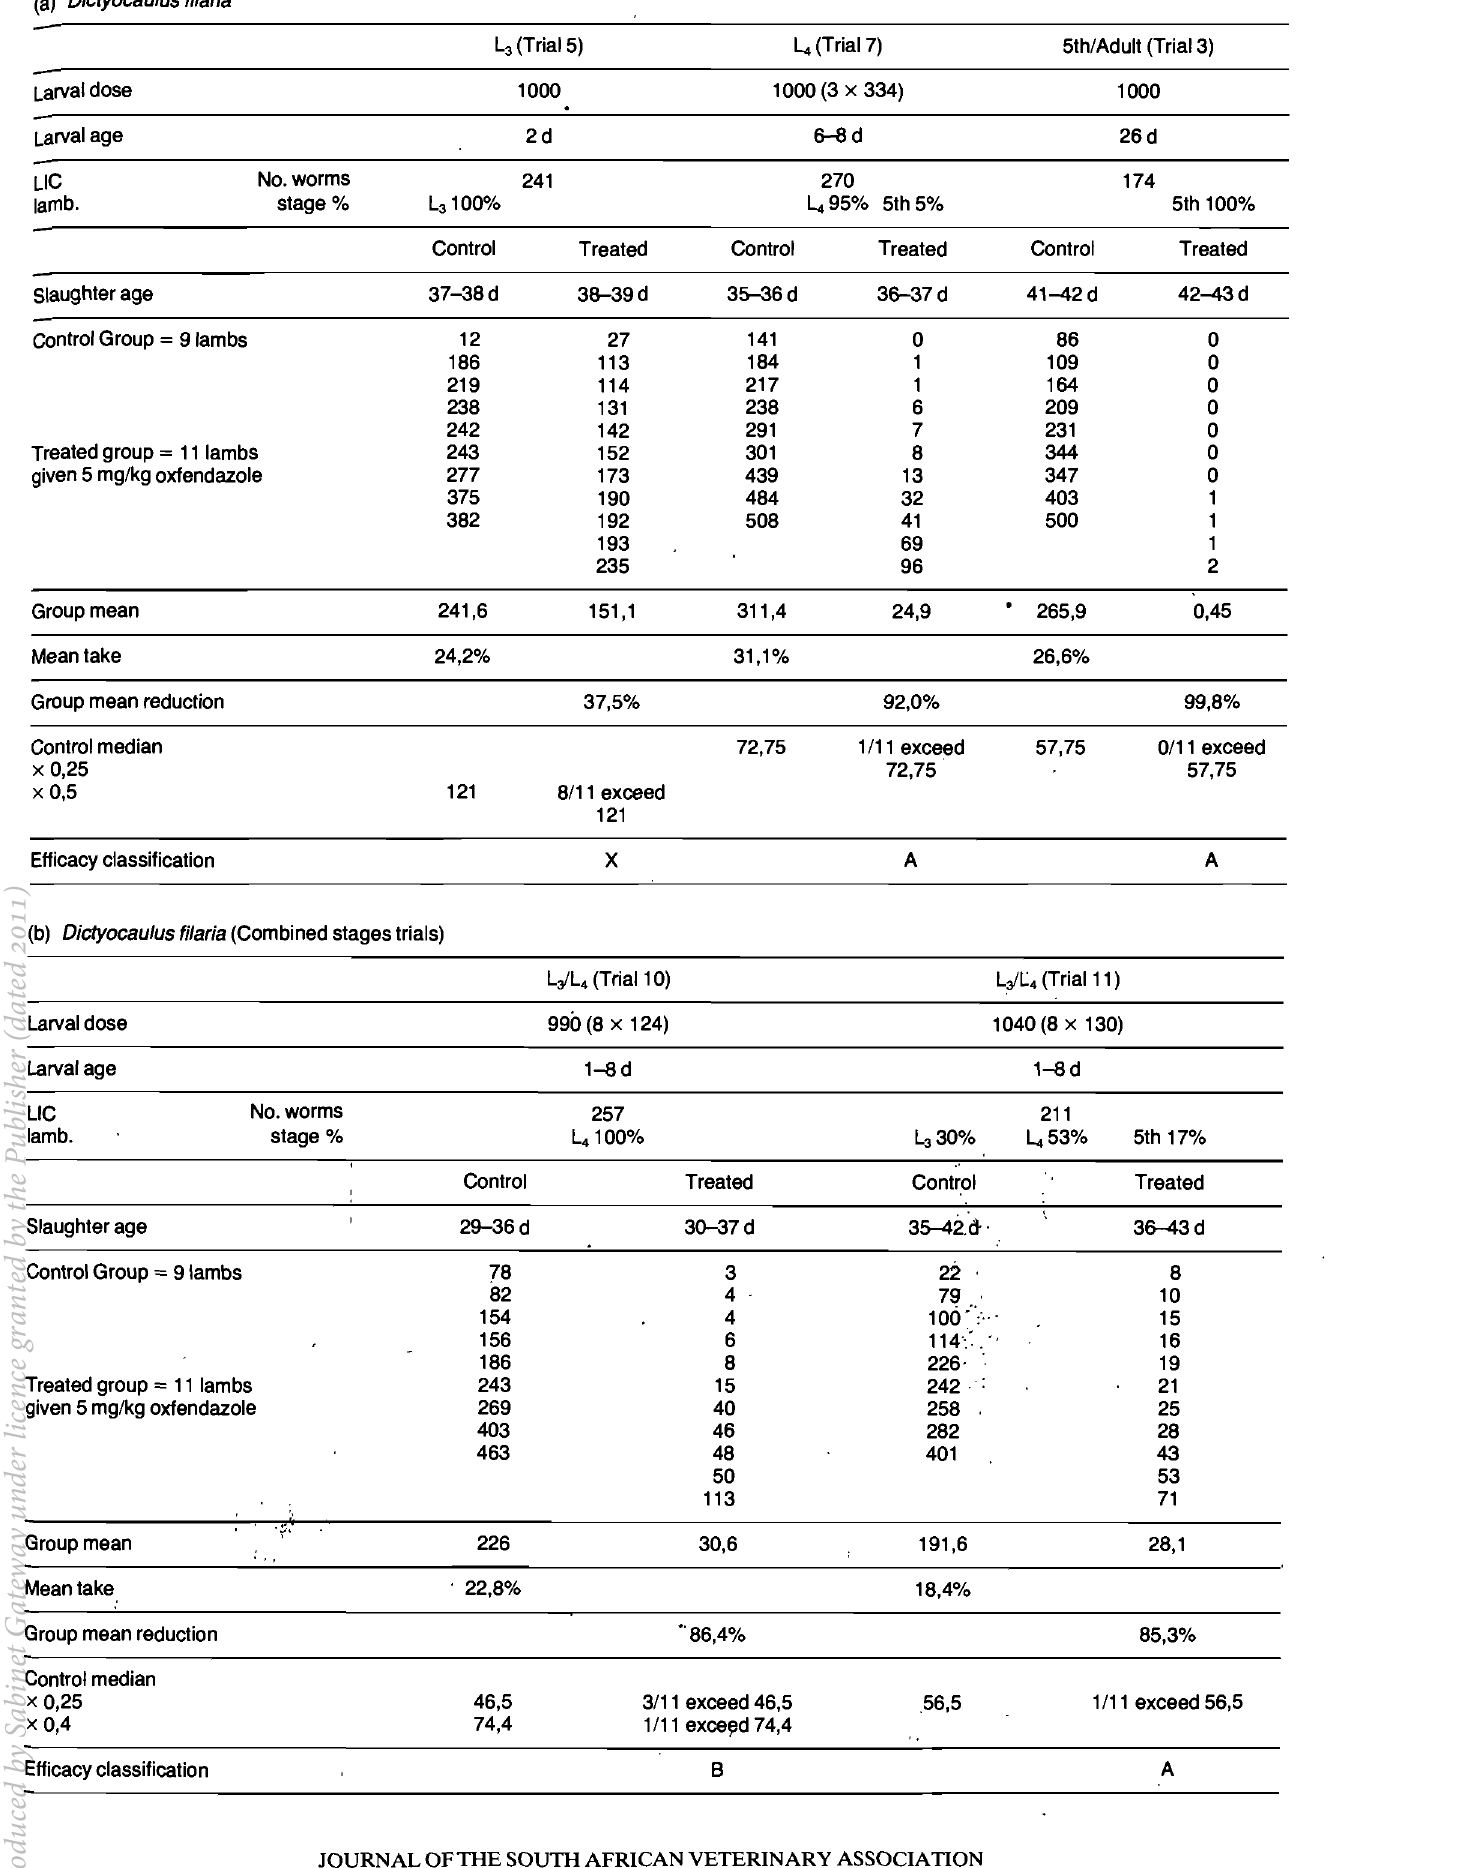
Table 2: LARVAL INFECTION RATES, LARVAL AGES AT TIME OF TREATMENT AND SLAUGHTER, RANGE OF WORMS RECOVERED AT NECROPSY, PERCENTAGE REDUCTION IN WORM BURDENS AND EFFICACY CLASSIFICATION (a) Dictyocaulus filaria